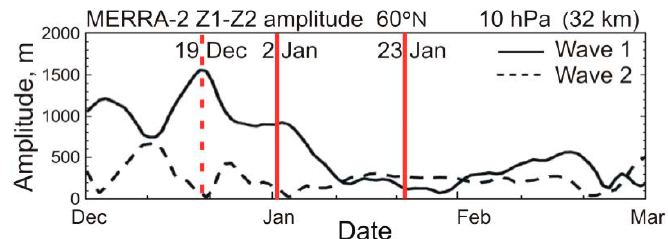
Figure 2. Wave 1 and wave 2 amplitudes in geopotential height at 60°N, 10 hPa, in December 2018–February 2019 by the MERRA-2 time series data [41]. The SSW2 event is bounded by red vertical lines. The dashed red vertical line marks the beginning of zonal wind reversal from the local microwave radiometer (MWR) measurements in December